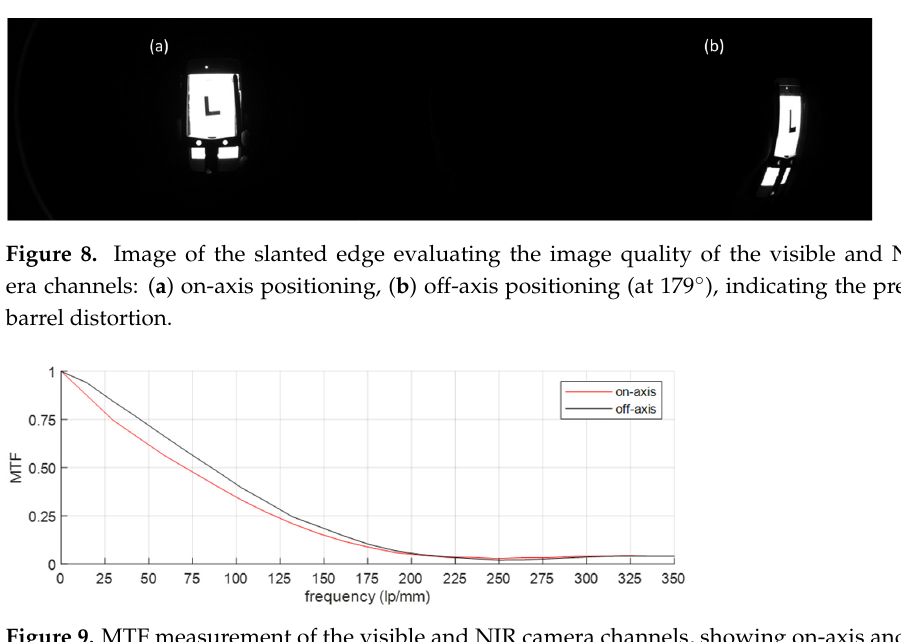
Figure 9. MTF measurement of the visible and NIR camera channels, showing on-axis and off-axis (at 179 ◦ ) positioning of the object, indicating good image